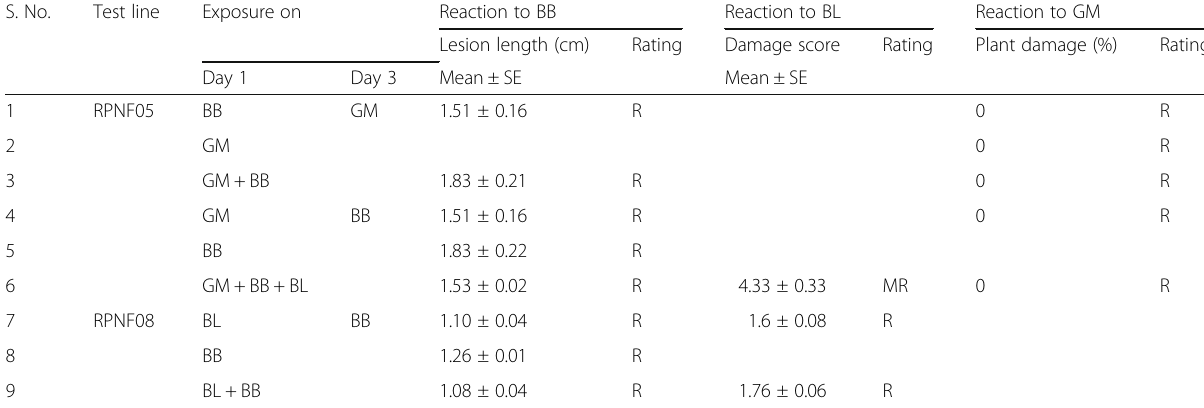
Table 3 Disease or pest reaction of the gene pyramided lines under sequential or simultaneous exposure to the pests S.